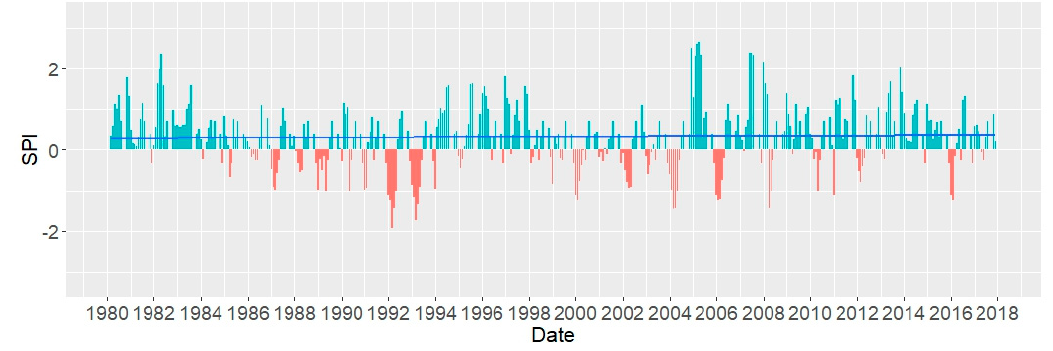
Figure 5. Three-month SPI of the Quetta station.